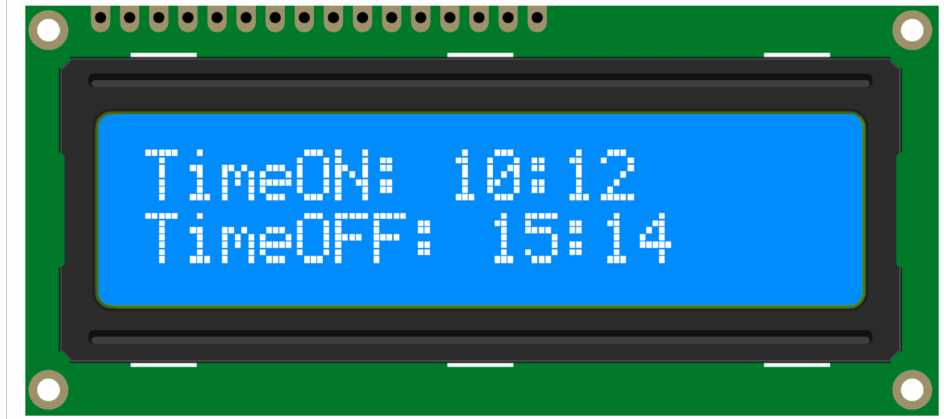
Figure 12. Exemplary screen of the lighting period control